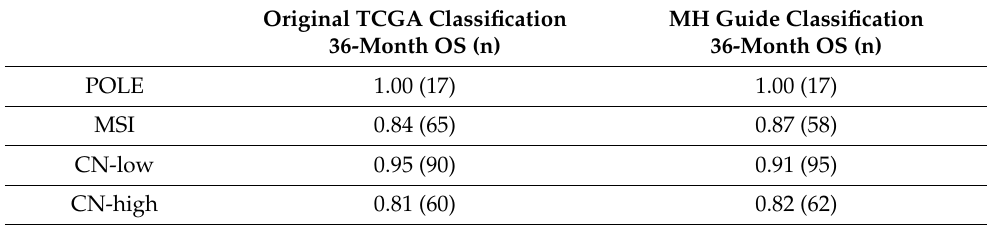
Table 3. The 36-month OS of subtypes by original TCGA classification and MH Guide algorithm.